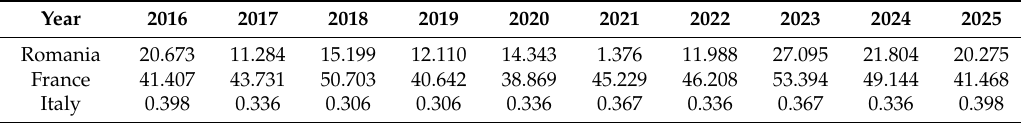
Table 11. The biodiesel potential for rapeseed (thousand tons). Source: authors’ own calculation based on [56].